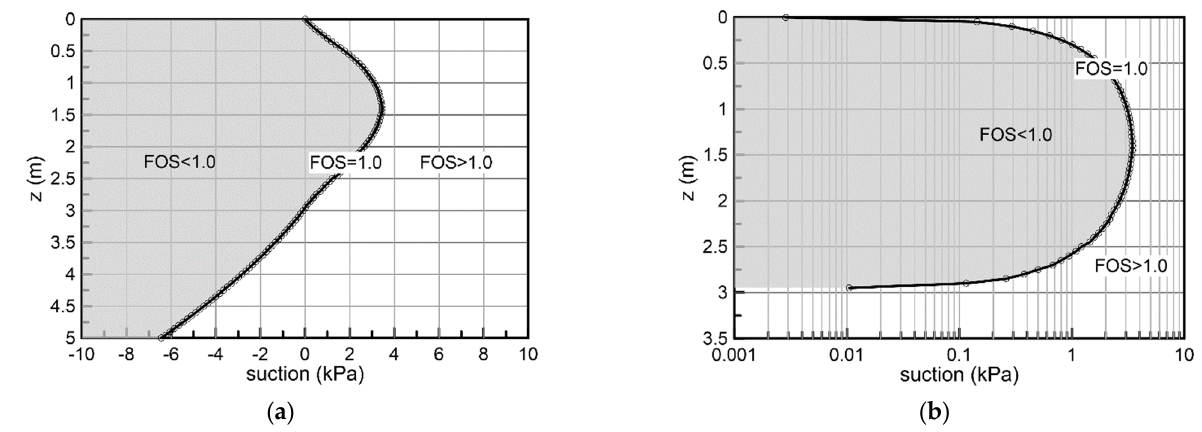
Figure 9. Stability chart; ( a ) stable vs. unstable suction and slope height combinations; ( b ) as ( a ) in a semilogarithmic plot; results from a 3D mechanism (with lateral resistance).